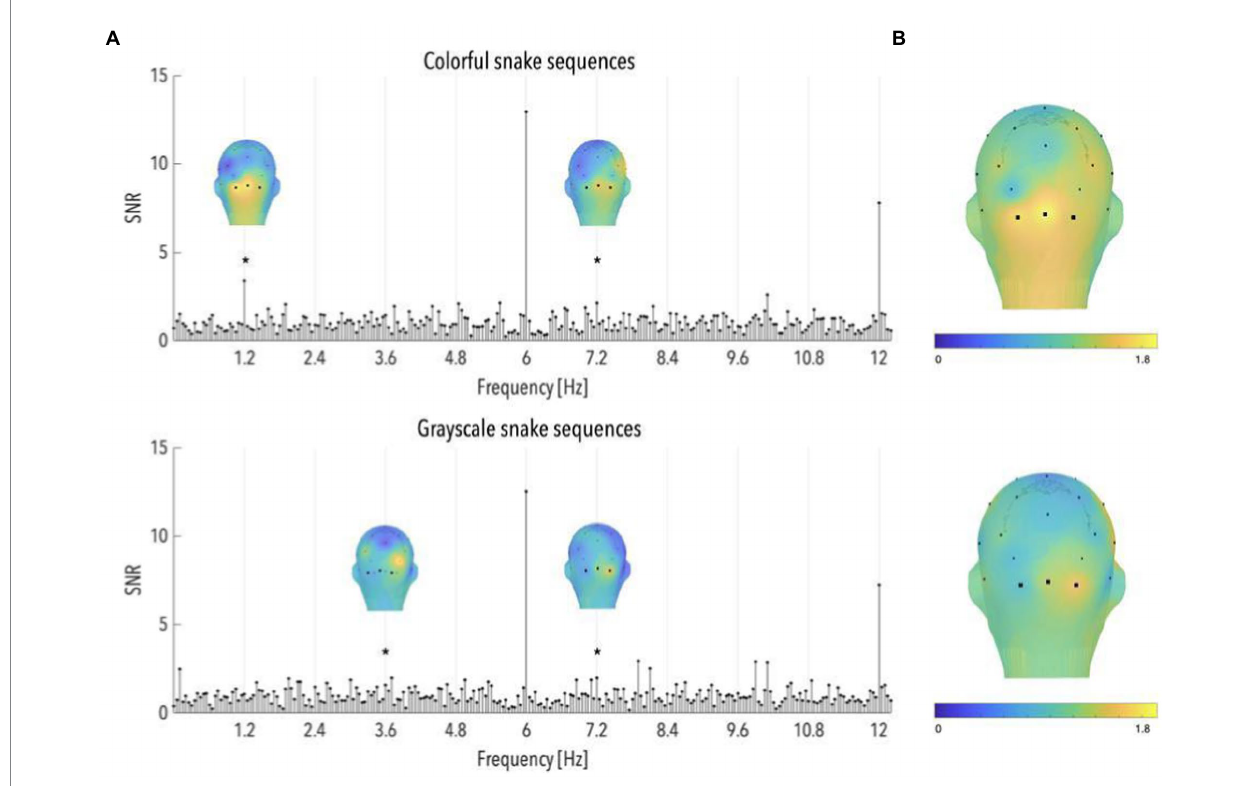
FIGURE 4 (A) Signal-to-noise ratio (SNR) spectra of category-selective and stimulation responses until 12 Hz, in the occipital region (data have been averaged across O1, Oz, and O2), and topographical maps of SNR over posterior scalp regions at significant category-selective frequencies, for colorful and grayscale snake sequences ( n = 55 and 32, respectively). The topographies at the harmonics are shown on their individual maximal color scales. The asterisk indicates a significant discrimination response in the occipital region, of colorful and grayscale snake pictures. (B) Topographical maps of SNR averaged on the first six harmonics of the category-selective response, for colorful and grayscale snake sequences (upper and lower part,